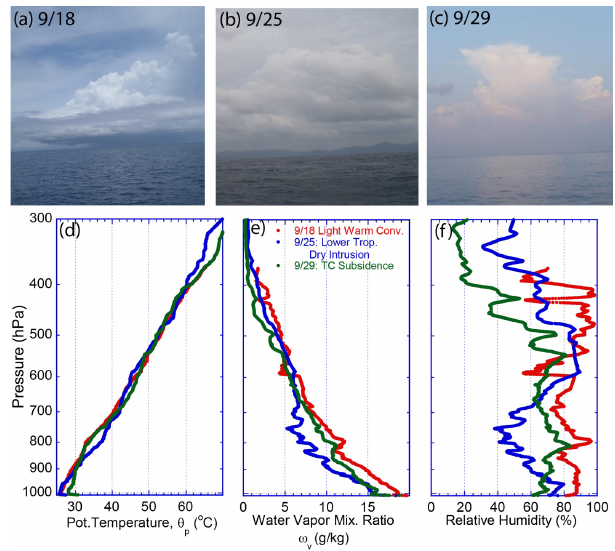
Figure 8. Photographs and corresponding sounding elements for three aerosol regimes during periods of marginal convection. (a) 18 September at Apo reef with isolated warm convection in mod- erately moist conditions; (b) 25 September at El Nido with warm non precipitating convection with a lower troposphere dry intru- sion during the height of the pollution event; (c) 29 September at the northern Sulu Sea with isolated deep convection in overall TC induced subsidence during height of biomass burning event. (d–f) Corresponding Vasco released radiosonde profiles of potential tem- perature, water vapor mixing ratio, and relative humidity, respec-